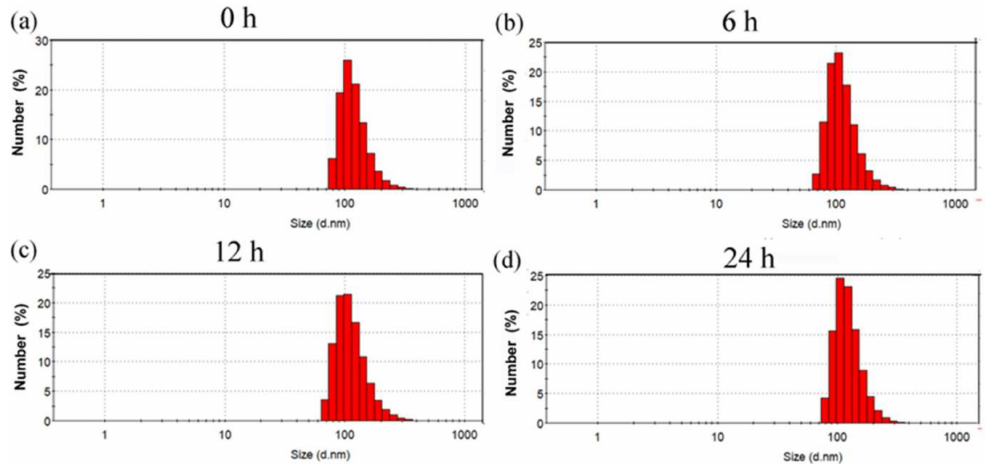
Figure 3. Particle size changes in (CP) 6 NS at room temperature for ( a ) 0 h, ( b ) 6 h, ( c ) 12 h, and ( d ) 24